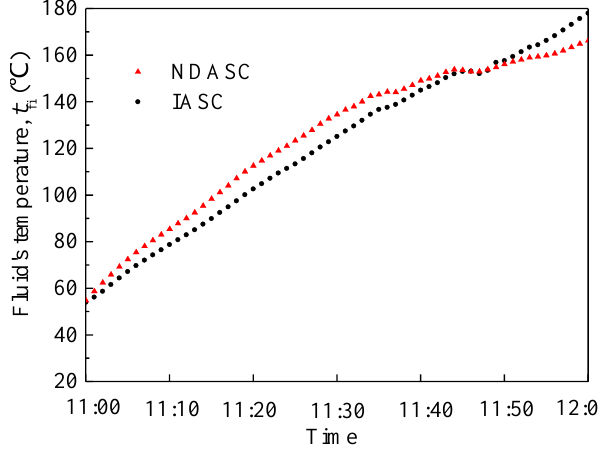
Figure 12. Variations of working fluid’s temperatures with time for two